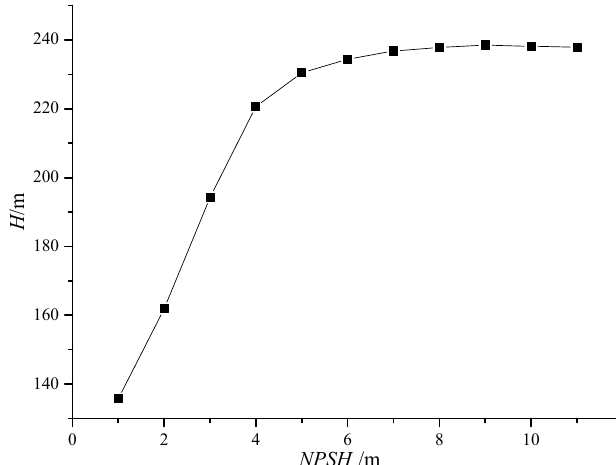
Figure 6. Cavitation performance curve of the LNG submersible pump.